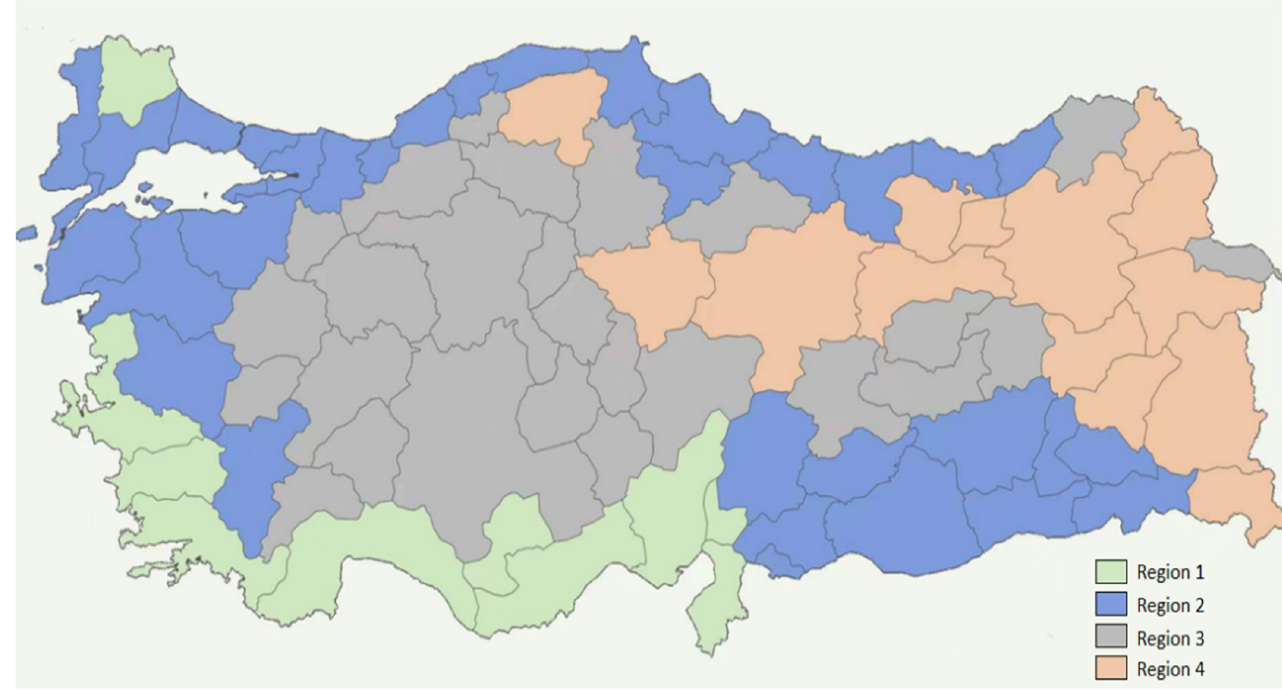
Figure 10. The four climate regions in Turkey [93].